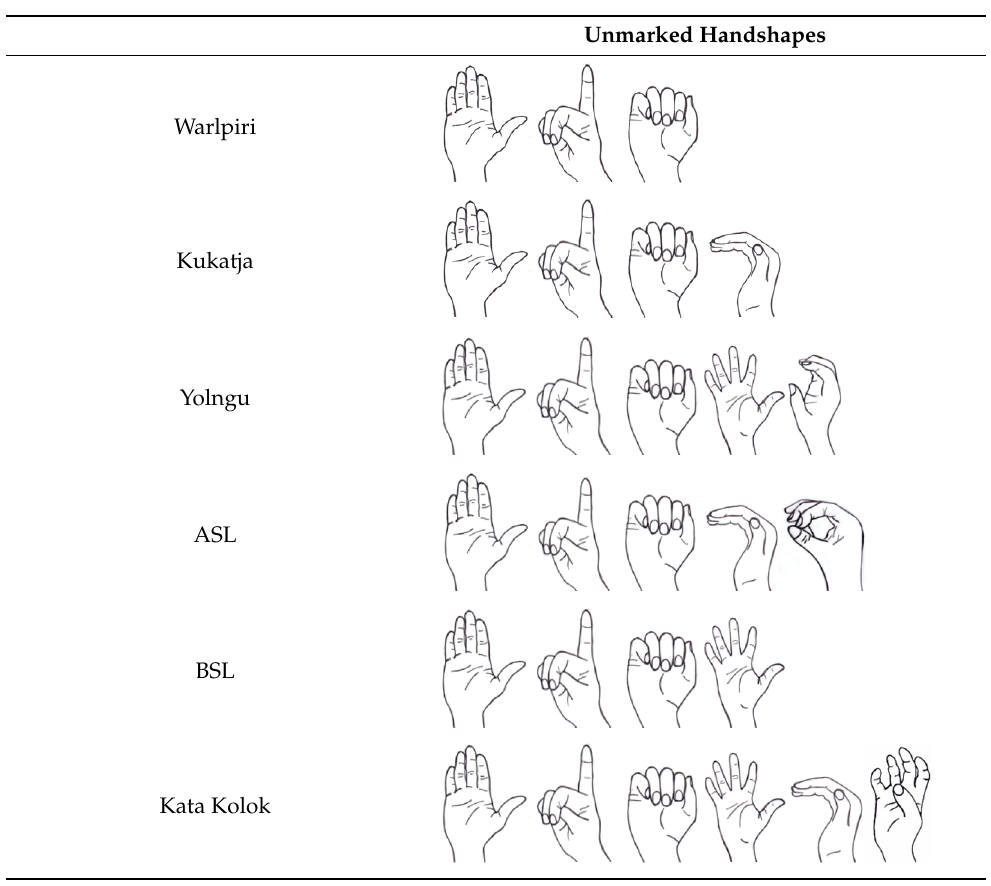
Table 3. Unmarked handshapes in a number of sign